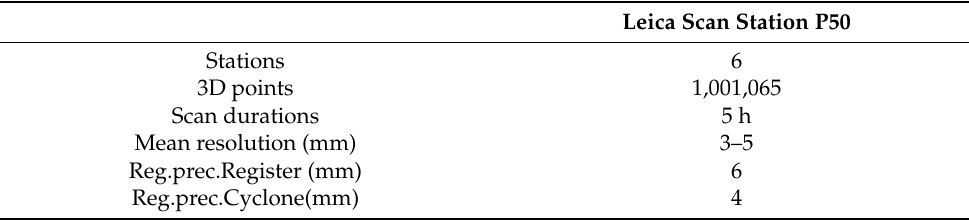
Table 3. Laser scan